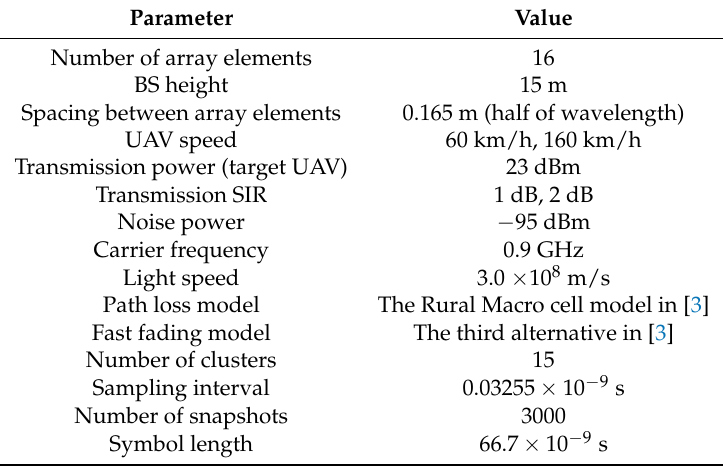
Table 2. Simulation